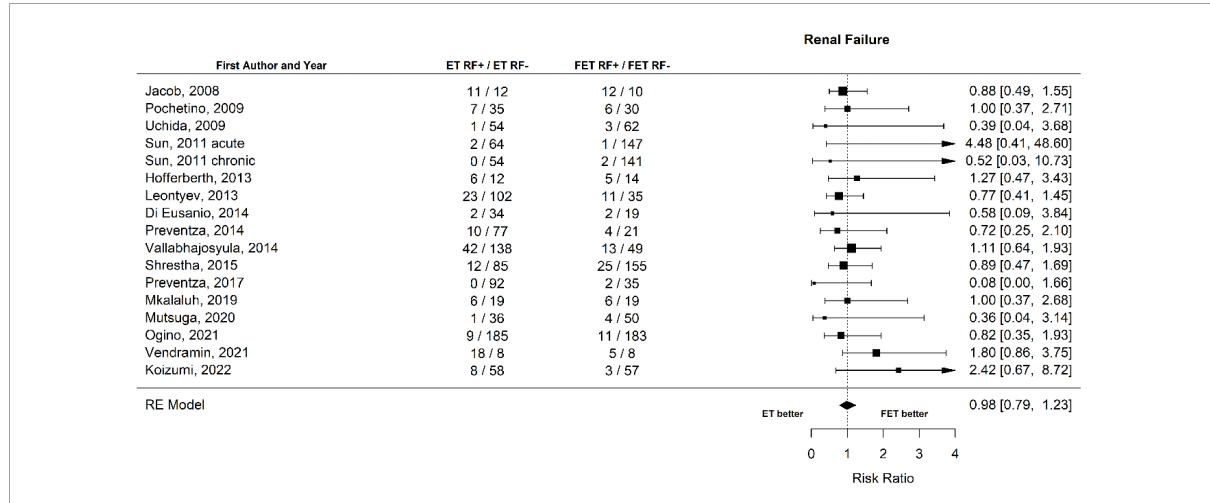
FIGURE8 Relative risk of renal failure (RF) in patients undergoing aortic interventions with conventional elephant trunk (ET) vs. frozen elephant trunk (FET). Forest plot p =